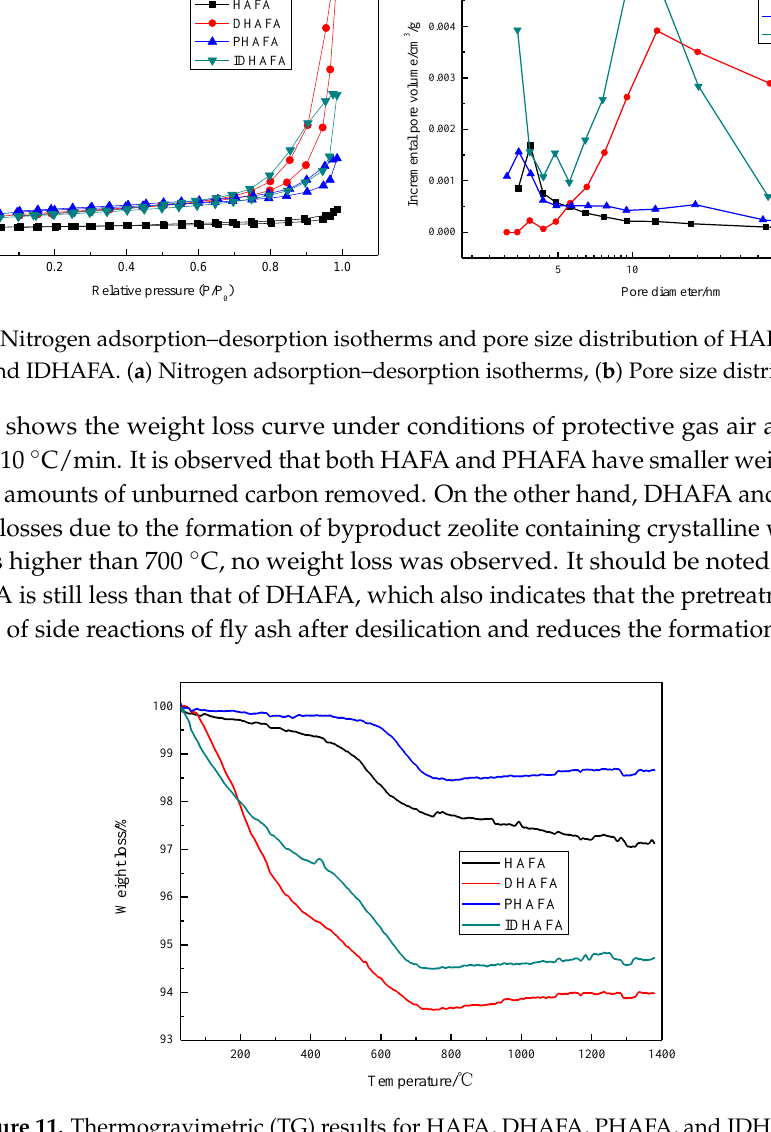
Figure 11. Thermogravimetric (TG) results for HAFA, DHAFA, PHAFA, and IDHAFA.